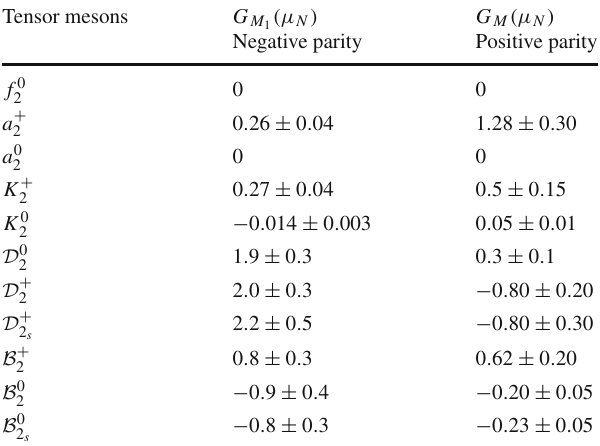
Table 1 The working regions of the Borel parameter M 2 , and the corresponding values of the continuum threshold s 0 for the J PC = 2 −− tensor mesons (these values are taken from [6])